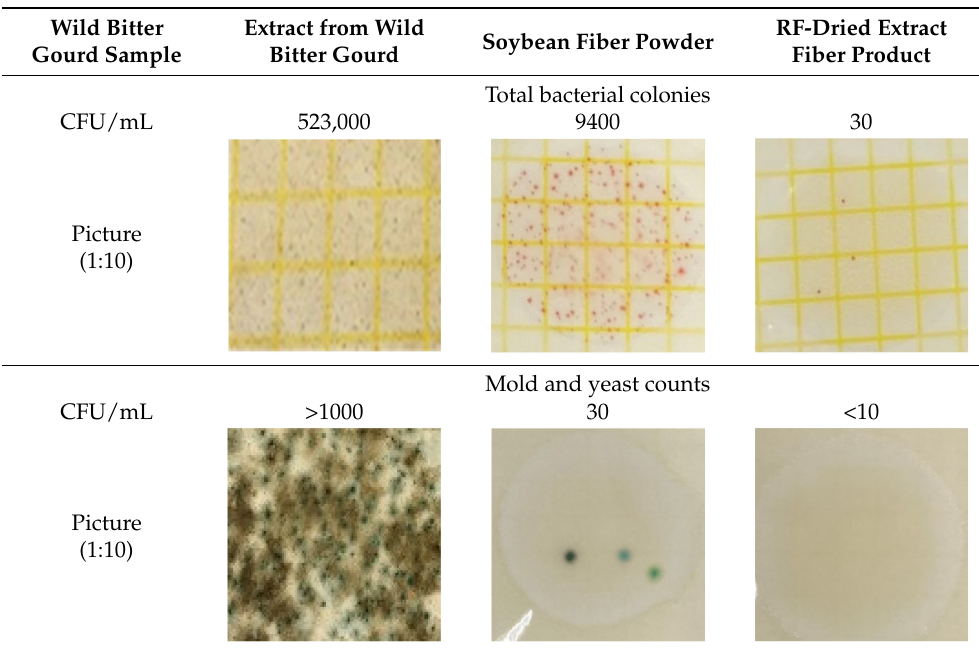
Table 3. Total counts and mold and yeast counts for wild bitter gourd extract, soybean fiber powder, and RF